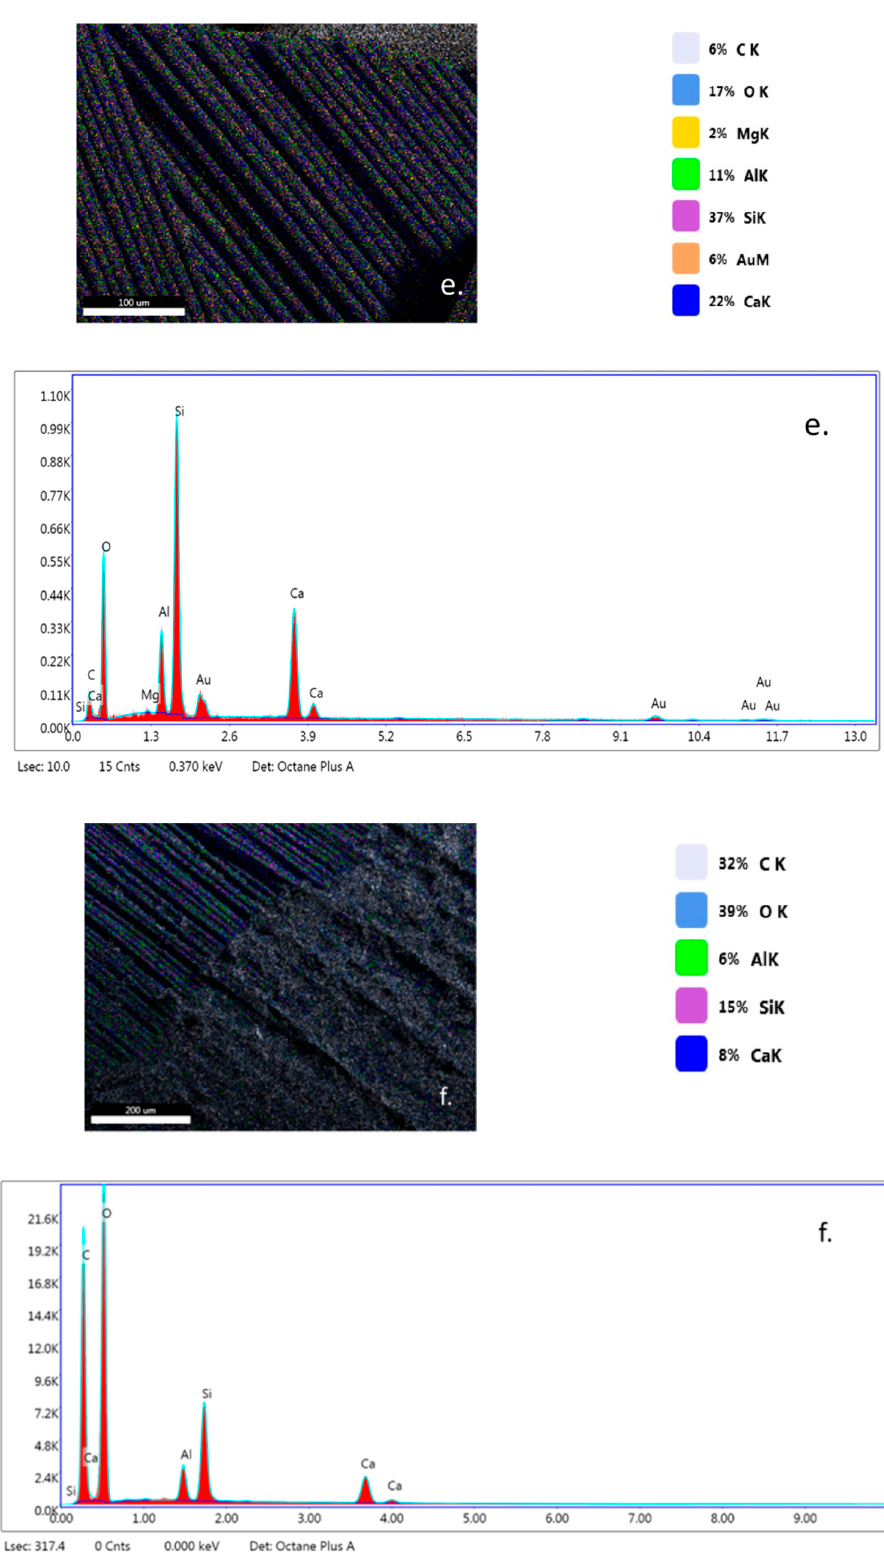
Figure 7. Energy-dispersive X-ray (EDX) patterns for fibersglass covered with PLA/TiO 2 hybrid nanofibers: ( a ) fabric plain woven-type (EWR); ( b ) fabric mat-type (EMC); ( c ) fabric one fold edge-type (TEX); ( d ) fabric plain woven-type (EWR)—after photocatalysis; ( e ) fabric mat-type (EMC)—after photocatalysis; ( f ) fabric one fold edge-type (TEX)—after photocatalysis.